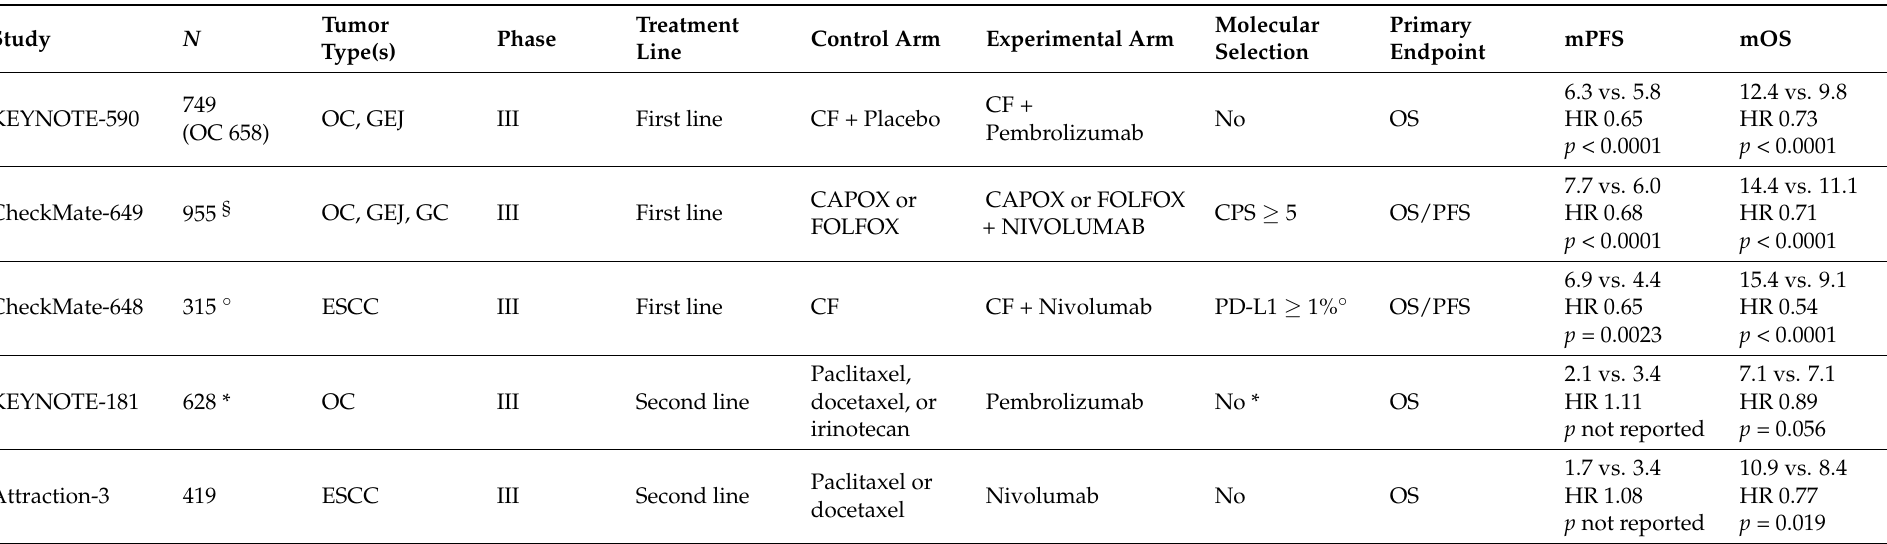
Table 1. Immune checkpoint inhibitor trials in metastatic oesophageal